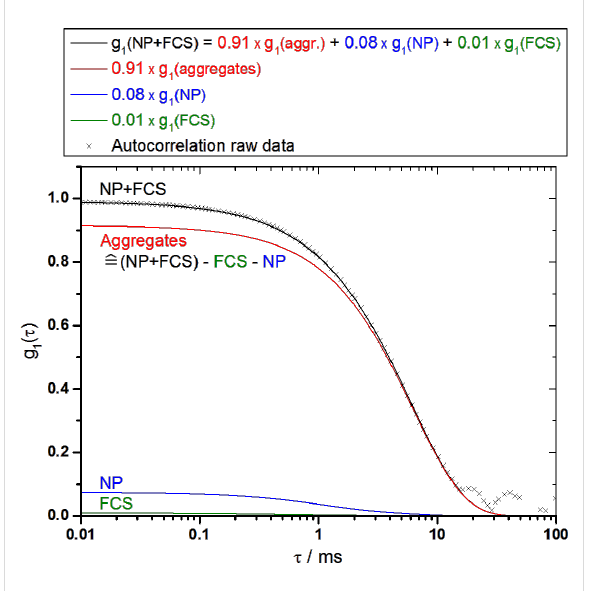
Figure 3: Multicomponent analysis [28] to evaluate the DLS measure- ment of the mixture of amorphous silica nanoparticles (NP) and serum proteins (FCS) at a scattering angle of 30°. As serum proteins (green), pristine nanoparticles (blue) and an additional fraction of agglomer- ates (red) contribute to the measured autocorrelation function g 1 ( τ ) (black crosses), the combined fitting function (black) also comprises contributions of these three components. The corresponding ampli- tudes are 0.01, 0.08 and 0.91,